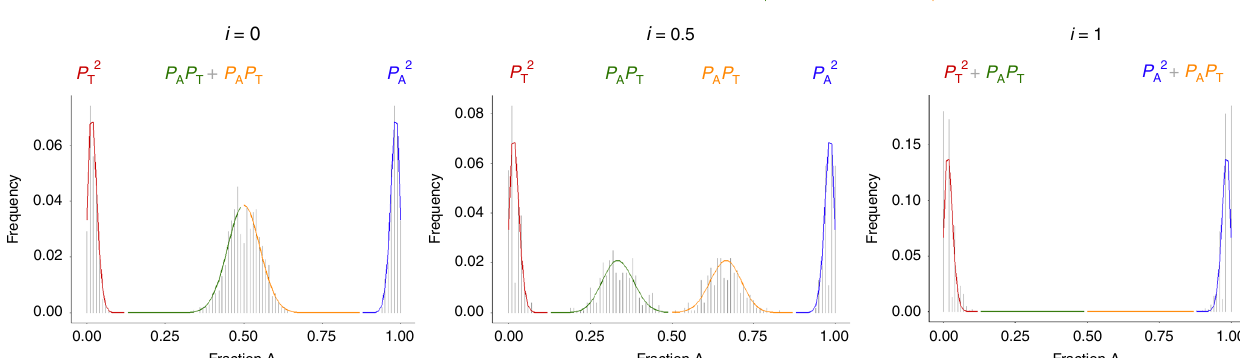
Fig. 5 Graphical representation of rationale of the PMF. a The PMF is de fi ned as a mixture model of genotype-dependent binomial distributions and describes the probability of observing speci fi c RNA-seq coverages for each allele for a speci fi c SNP locus. In these binomial probabilities, sequencing error rates, degree of imprinting ( i ) as well as the speci fi c genotype are taken into account. For non-imprinted loci, the PMF results in two homozygous peaks and one heterozygous peak. For imprinting, on the other hand, no heterozygous can be detected on RNA-level and this peak is hence eliminated. Heterogeneous data leads to the detection of partial imprinting. b PMF for different degrees of imprinting. In this mixture model, the genotype-dependent binomial distributions have weights corresponding to their Hardy – Weinberg theorem derived expected